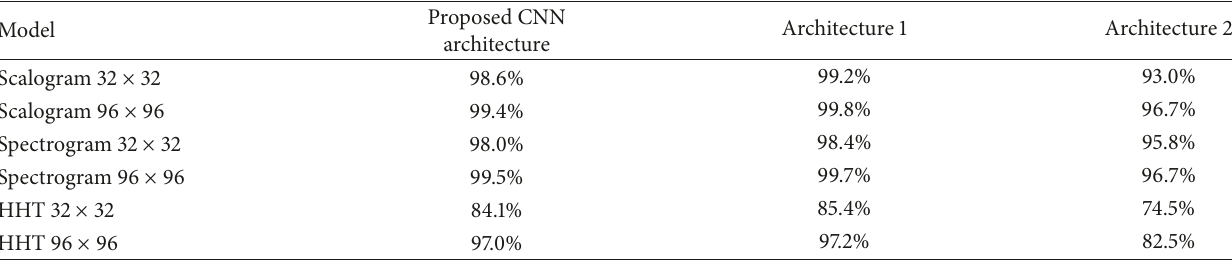
Table 22: Precision for CWR data set.